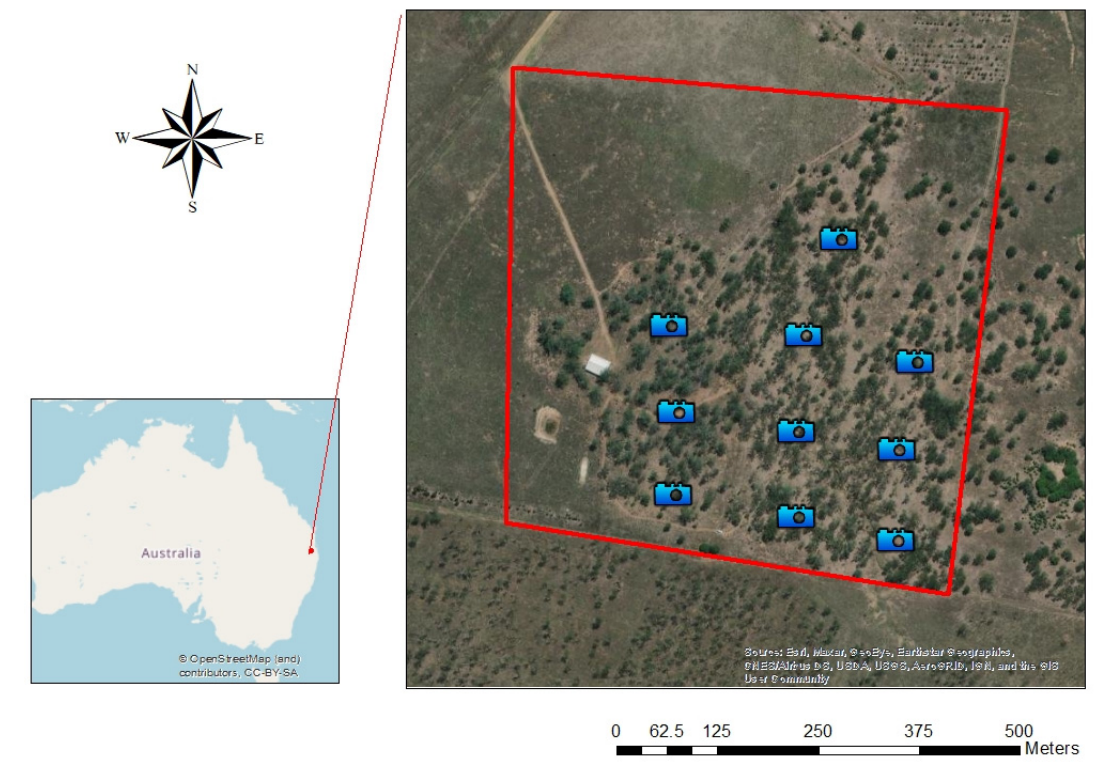
Figure 1. Old Hidden Vale Koala Hot Spot, with 10 cameras evenly distributed within the area with trees. Table 1. The dates, number of days and the number of cattle and koalas studied in the four koala reaction tests.